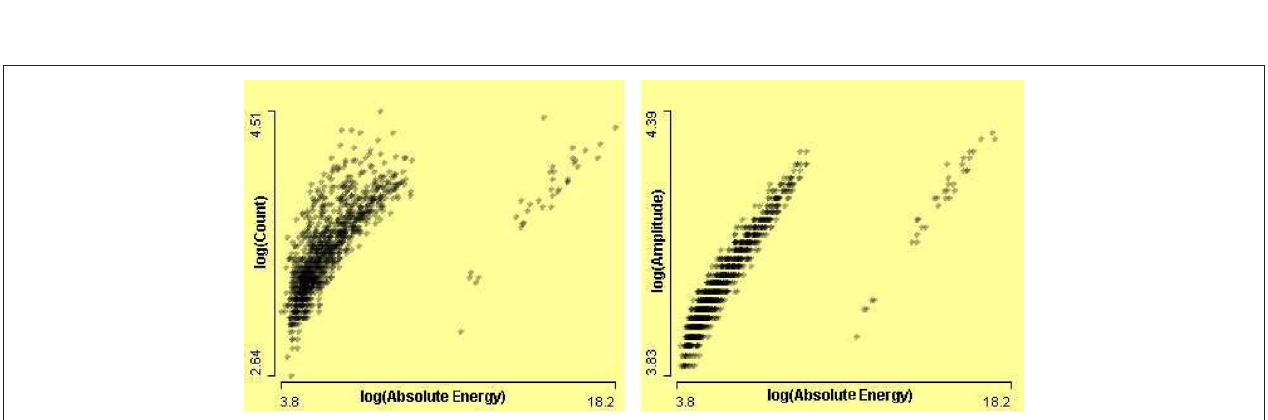
FIgurE 14 | In the left grid of 128 × 128, value of magnetics 255 is selected, and in the right grid, values of magnetics from 250 to 254 are selected.